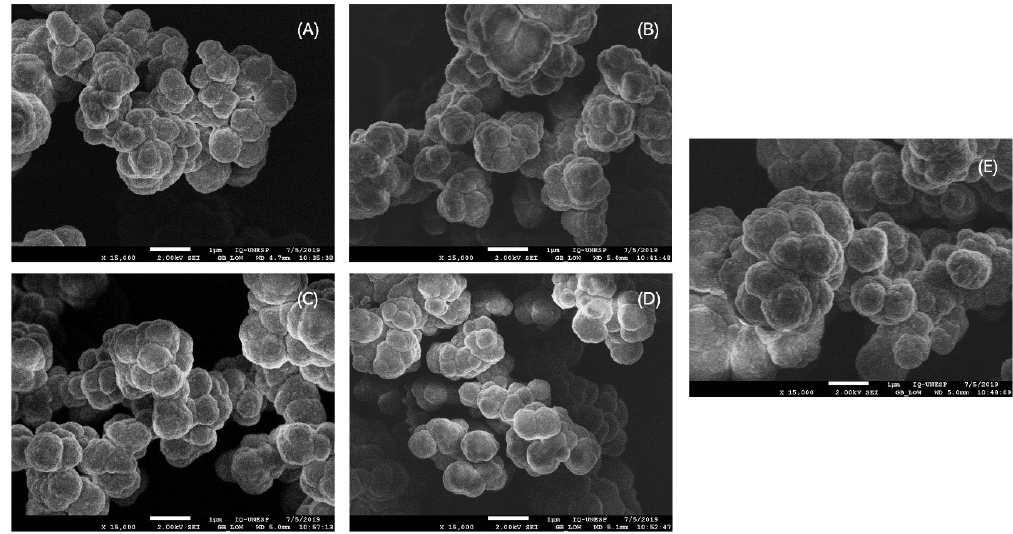
Figure 3. Figure 3. SEM images of ( A ) IIP–MBI–AA, ( B ) non-imprinted polymer (NIP)–MBI–AA, ( C ) IIP–MBT– AA, ( D ) NIP–MBT–AA, and ( E ) NIP–AA; the scale bar is 1 µm in all figures. Table 2. Calculated Brunauer–Emmett–Teller (BET) surface area, total pore volume and average pore size.